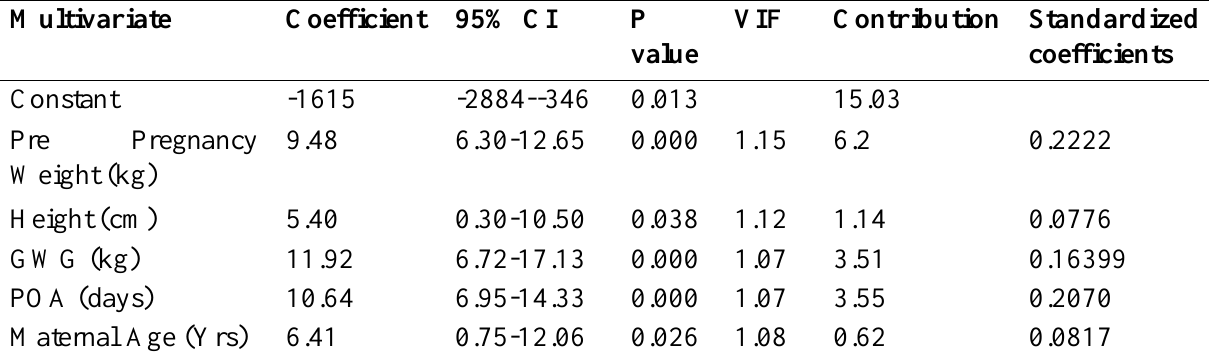
Table 05 - Multiple linear regression analysis showing the effect of maternal anthropometric characteristics on neonatal birth weight (Final model)